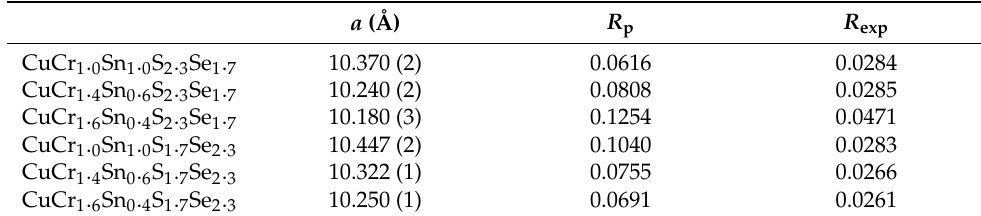
Table 2. Cell a parameters and R -indices obtained from Rietveld refinement of PXRD patterns of